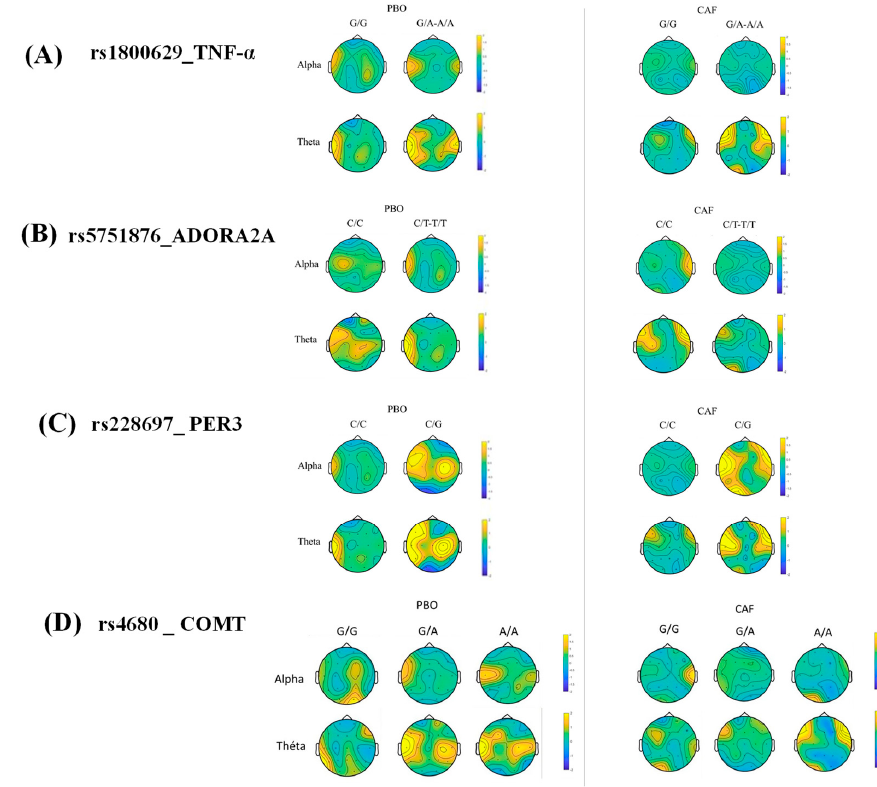
Figure 4. EEG theta and alpha normalized power on D2 day (sleep deprivation) relative to D1 day (baseline) (z-score) on brain scalps during PVT at 09:15 according to polymorphisms of TNF- α ( A ), ADORA2A ( B ) and PER3 ( C ), and COMT ( D ) in placebo (PBO) and caffeine (CAF) conditions. Caffeine was consumed 45-min before PVT at D1 and D2. For the ADORA2A SNP effect on PVT lapses, there is a significant interaction with TSD ( p < 0.02), but not with TRT (Table 2). Post-hoc analysis showed higher lapses in T allele carriers compared with C/C genotype carriers at 32-h of awakening (Figure 3B). With respect to the effect of ADORA2A SNP on speed or KSS, there is no significant ANOVA interaction (Table 2). For speed, there was no significant difference between gen- otype carriers during TSD (Supplementary Figure S1B). Finally, the EEG spectral analysis on brain scalps showed no genotype-related difference on the theta activity either in PBO or CAF condition (Figure 4B) (16 subjects were C/T, 2 were T/T, and 13 were C/C). The ANOVA analysis on theta-to-alpha ratio in response to sleep deprivation (D2 and D1 days) in the frontal region showed a significant interaction of ADORA2A SNP with TSD (Supplementary Table S2). without significant post-hoc. In the centrotemporal region, there is no significant interaction of ADORA2A SNP with TSD, but the interaction be- tween TSD and TRT (Supplementary Table S2), without significant post-hoc. For the PER3 SNP (rs228697) effect on PVT, there is significant 2-way interaction with TRT for lapse number and speed, but no interaction with TSD ( p < 0.08 and p = 0.82, re- spectively) (Table 2). In the CAF condition, there is a significantly lower number of lapses (compared with PBO condition) in G allele carriers at 20-h, and 32-h of awakening and this is present at 14-h, 20-h, and 32-h in C/C genotype carriers (Figure 3C). Concerning the speed, it was higher in the CAF condition (compared with PBO condition) in C/C geno- type carriers at 26-h of awakening, while no significance was present for G allele carriers (Supplementary Figure S1C). Concerning the KSS score, the PER3 SNP has no significant effect nor interaction with TSD or TRT (Supplementary Tables S1 and S2). Finally, the EEG